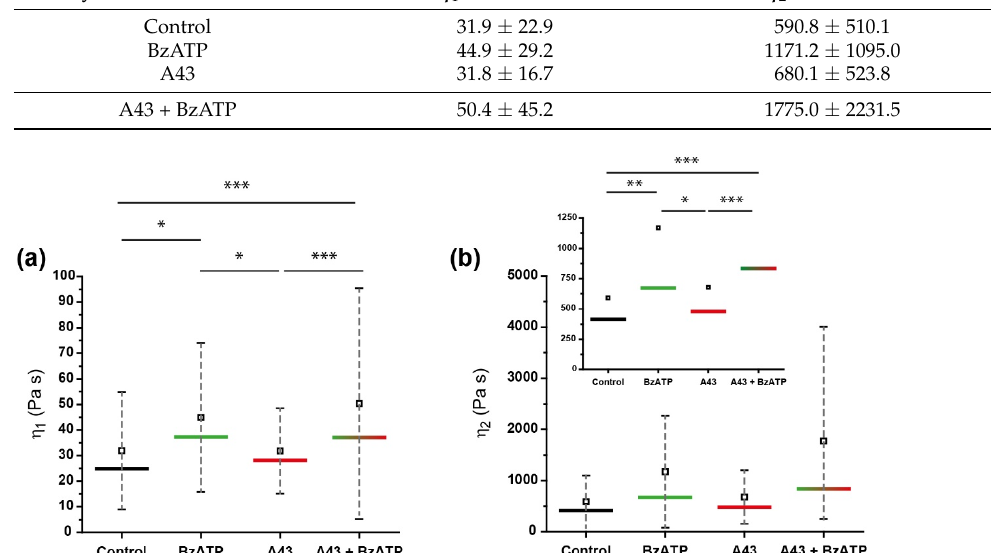
Figure 5. Calculated viscous moduli 1 ( a ) and 2 ( b ) for rat cerebellar astrocytes in control conditions (black line), or those treated with BzATP (green), A43 (red), or both (gradient). The horizontal line indicates the median, and the square refers to the mean value, which are shown numerically in Table 3. Whiskers indicate SD. Inset in ( b ) shows the same values in a shorter scale in order to appreciate the differences in the mean and the median. Statistically relevant variations p < 0.05, p < 0.01, and p < 0.001 are highlighted by *, **, and ***, respectively. Table 3. Statistics on pause segment (mean viscous moduli, 𝜂 (cid:2869) and 𝜂 (cid:2870) ). Error values indicate the standard deviation (SD). System (1 h Incu-